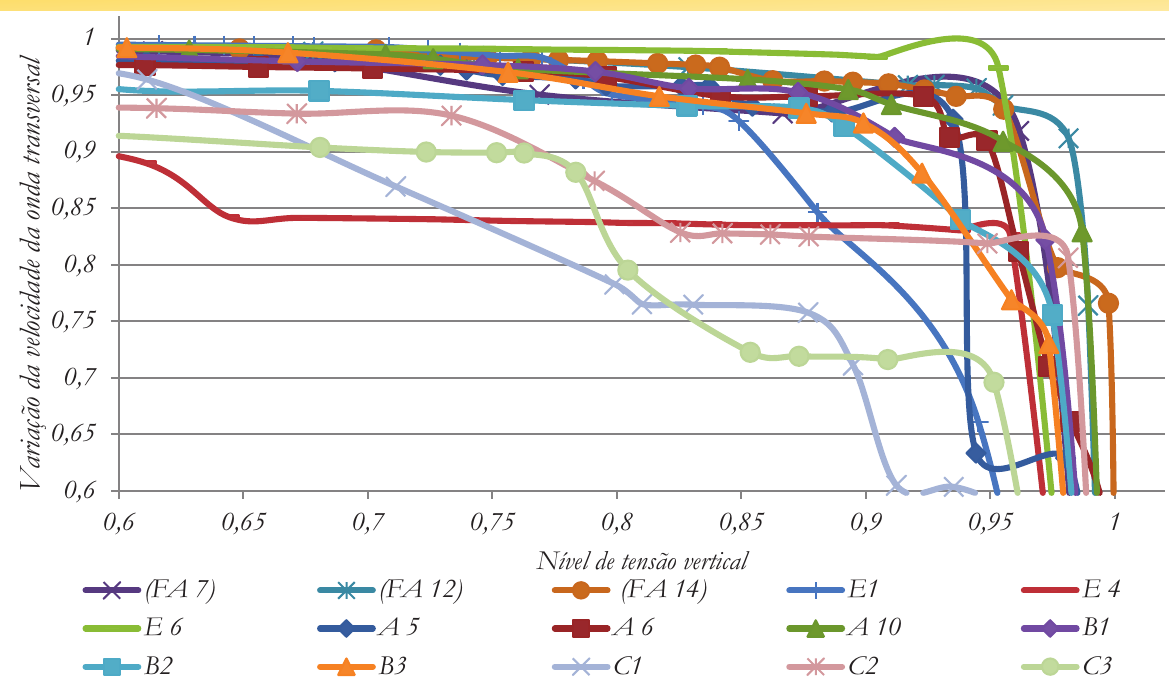
Figura 5 Resumo do comportamento da onda transversal em amostras de concreto submetidas à compressão simples